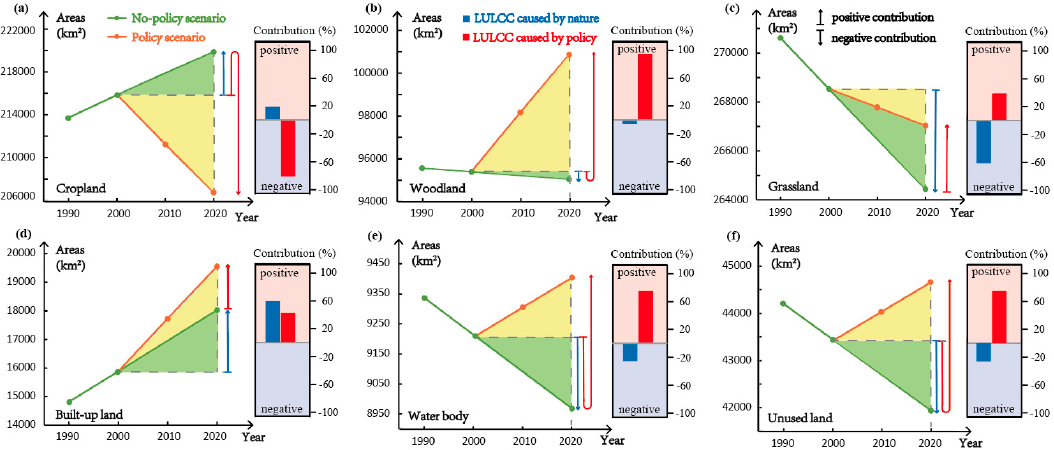
Figure 6. Trends of each type of land use and land cover under the no-policy and policy scenarios from 1990 to 2020, and the percentage of the relative contribution of nature and policy to the quantitative changes of each type. ( a – f ) Represent changes in the area of cropland, woodland, grassland, built-up land, water body, and unused land, respectively.